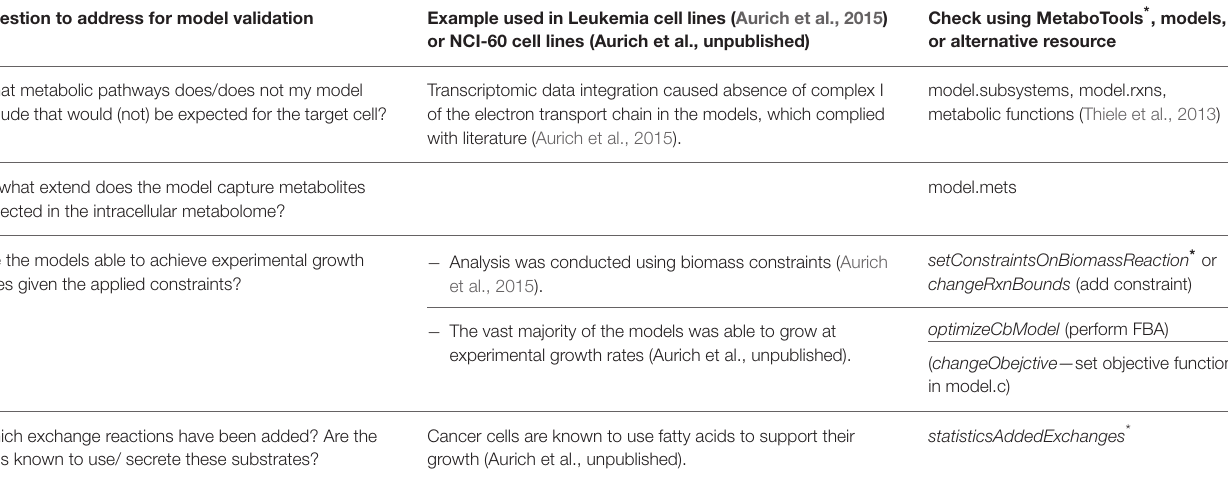
TABLE 3 | Use expectations to compare the generated models against. Question to address for model validation